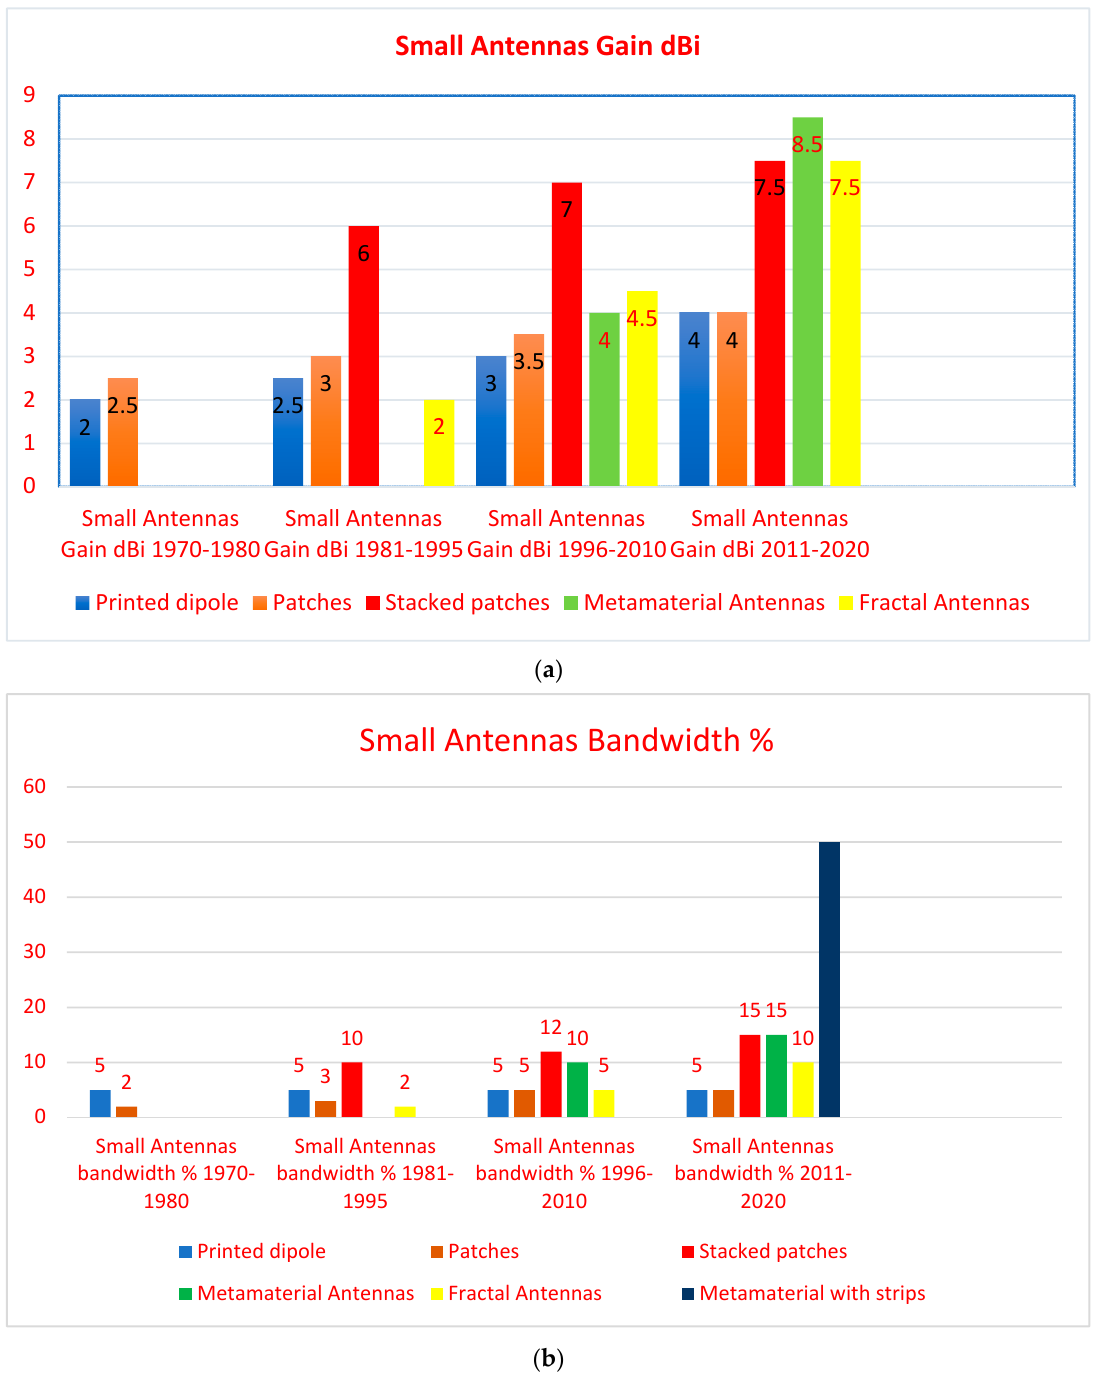
Figure 1. Progress in development of small antennas. ( a ) Small Antennas Gain; ( b ) Small Antennas bandwidth.